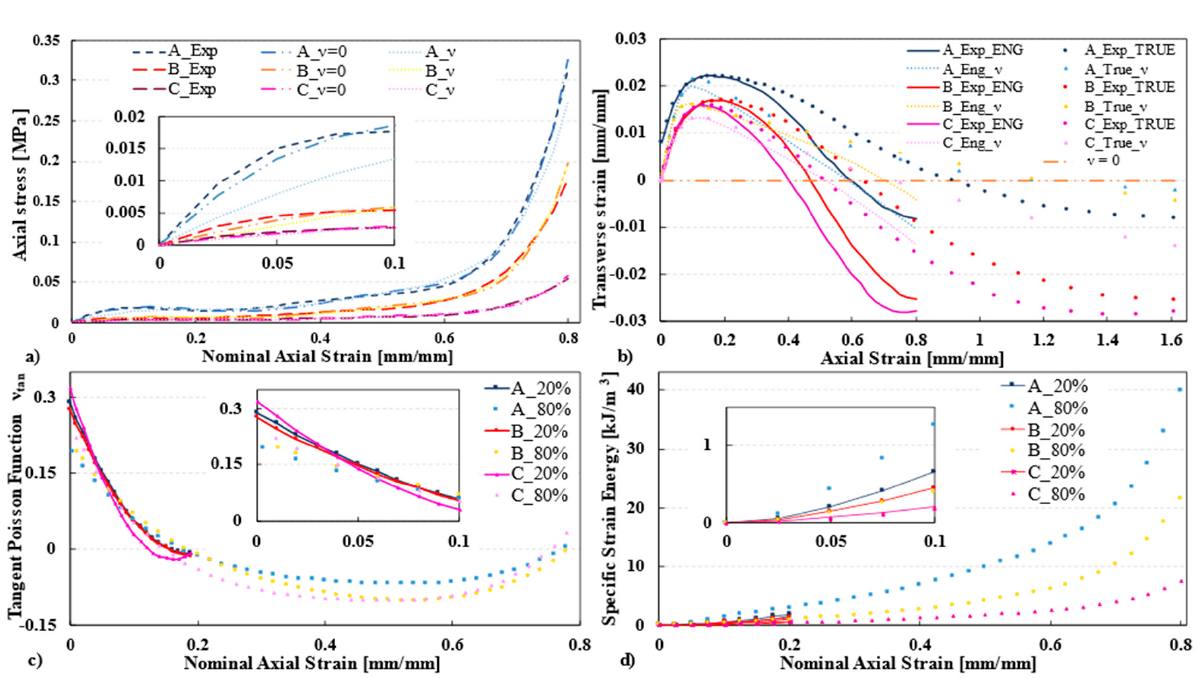
Figure 3. Comparison of the experimental and numerical axial stress–strain ( a ) and transverse vs. axial strain ( b ) curves obtained at 80% strain while considering ν = 0 and ν ≠ 0. Tangential Poisson’s function ( c ) and specific strain energy ( d ) for 20% and 80% strain. Table 3. Plateau stress σ pl and modulus of elasticity E 5% up to 5% of deformation and the plateau modulus E pl for the first and fourth compression cycles (20% and 80% of deformation).